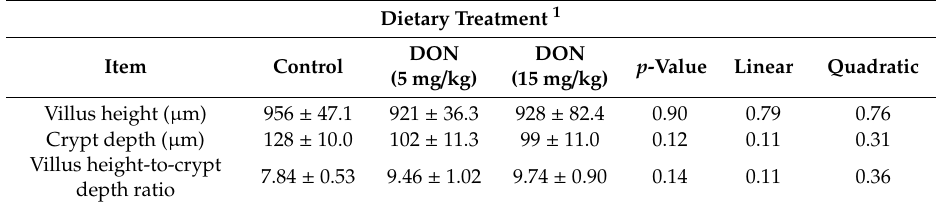
Table 5. E ff ects of DON-contaminated feed (5 and 15 mg / kg) on small intestine histology of broiler chickens.